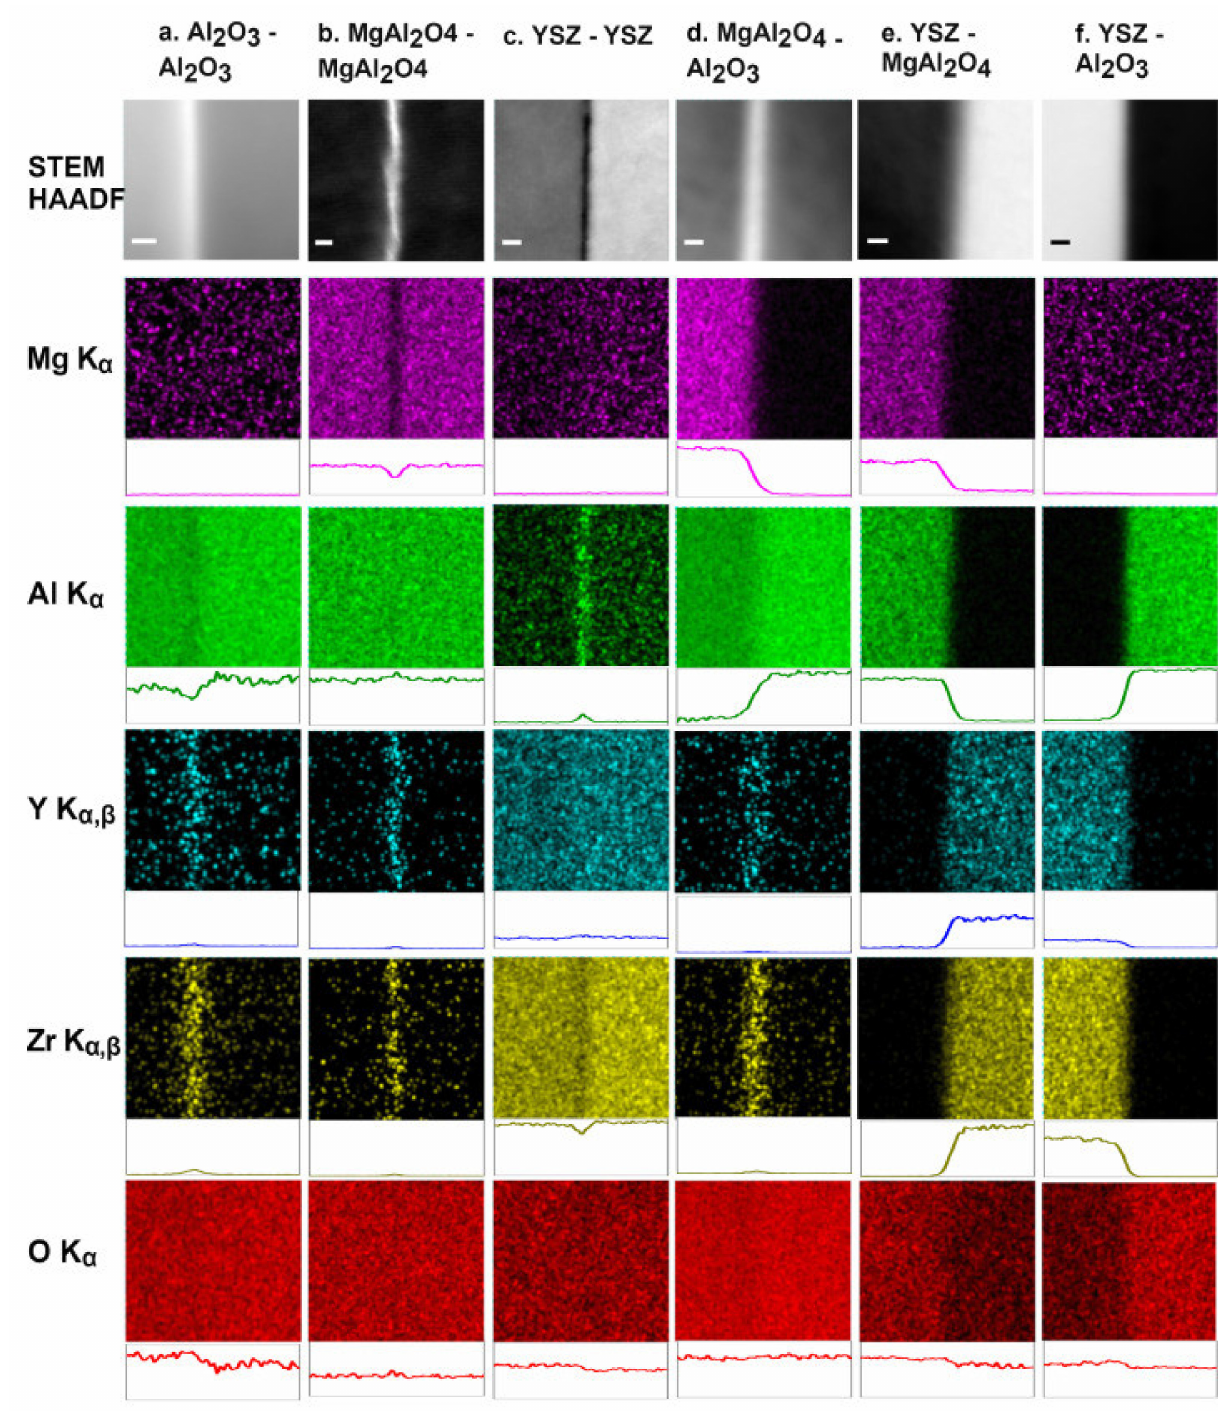
Figure 28. STEM HAADF images and EDXS maps for six (representative) interfaces in a flash-sintered MgAl 2 O 4 -Al 2 O 3 -YSZ ceramic. Mg K α , Al K α , Y K α , β , Zr K α , β and O K α elemental EDXS maps (net counts) and their corresponding intensity profiles (net counts normalized by the total counts) are shown. ( a ) Alumina-alumina GB shows depletion of Al and segregation of Y/Zr, ( b ) spinel-spinel GB shows depletion of Mg and segregation of Y/Zr, ( c ) YSZ-YSZ GB shows depletion of Zr and segregation of Al, ( d ) spinel-alumina GB shows segregation of Y/Zr, and ( e ) YSZ-spinel and ( f ) YSZ-alumina interfaces do not show any segregation. Scale bar is 2 nm [41]. Figure 28 reprinted from Acta Materialia, 14, Komal Syed, Mingjie Xu, Kenta K. Ohtaki, David Kok, Keyur K. Karandikar, Olivia A. Graeve, William J. Bowman, Martha L. Mecartney, Correlations of grain boundary segregation to sintering techniques in a three-phase ceramic, 100890, Copyright (2020), with permission from